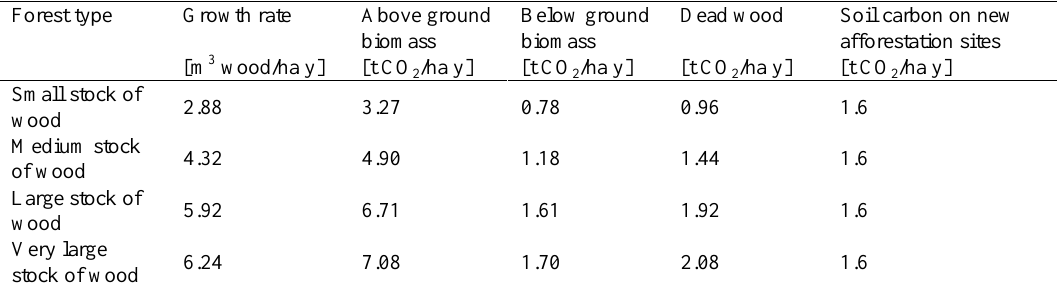
Table A4.1. Annual carbon sequestration rates for different carbon pools. Shown are mean values for the trend scenario. Values are higher in the climate scenario and lower on afforestation sites as described in the